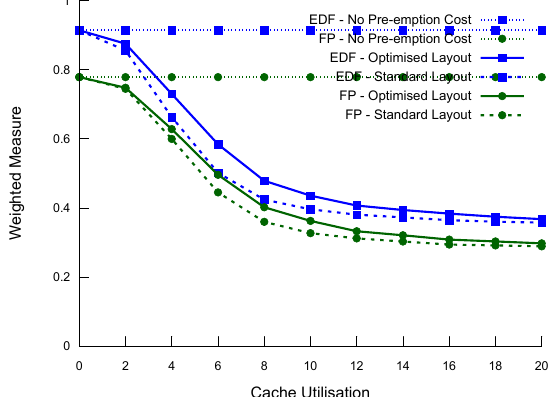
Figure 10 Weighted measure for varying the cache utilisation from 0 to 20 in steps of